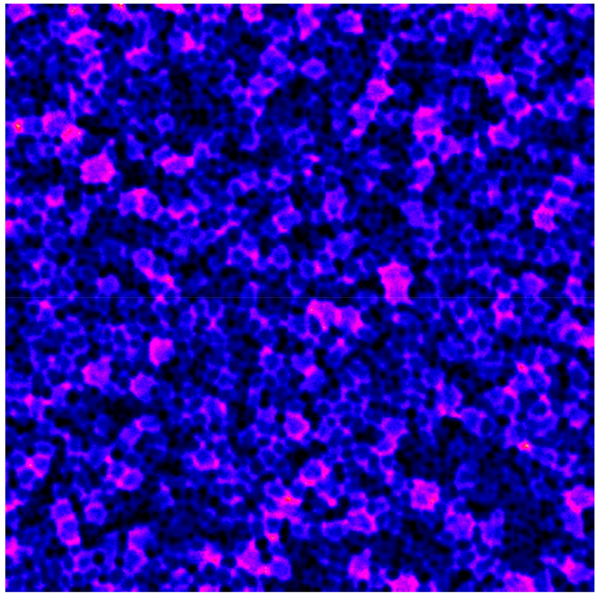
Figure 4. Confocal microscopy image of FA 0.85 MA 0.15 Pb 0.975 Zn 0.025 I 2.85 Br 0.15 -[CPACl] obtained by dividing the photoluminescence lifetime-image by the intensity-image (INT) thereby accentuating the grain boundary areas, as processed with Image-J (lifetime / INT, fire-color coding). The network of light blue lines highlights the special grain boundary e ff ect, which is in-fact induced by charge recombination interaction with the ITO surface (not observed on quartz). Pink spots are characterized by a very low emission intensity and long emissive lifetime. Image dimension is 20 × 20 µ m. See also Reference [16]. This picture is best viewed